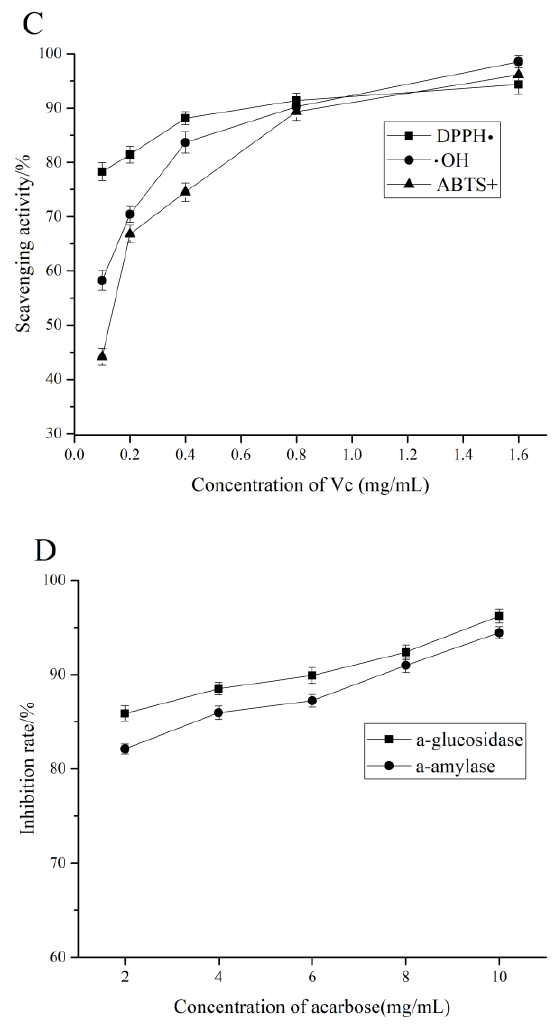
Figure 6. ( A ) The antioxidant activity in vitro of HCPS, ( B ) α -amylase inhibitory activity and α -glucosidase inhibitory activity of HCPS, ( C ) the antioxidant activity in vitro of Vc, ( D ) α -amylase inhibitory activity and α -glucosidase inhibitory activity of acarbose. Different lower-case letters were different significantly ( p < 0.05).